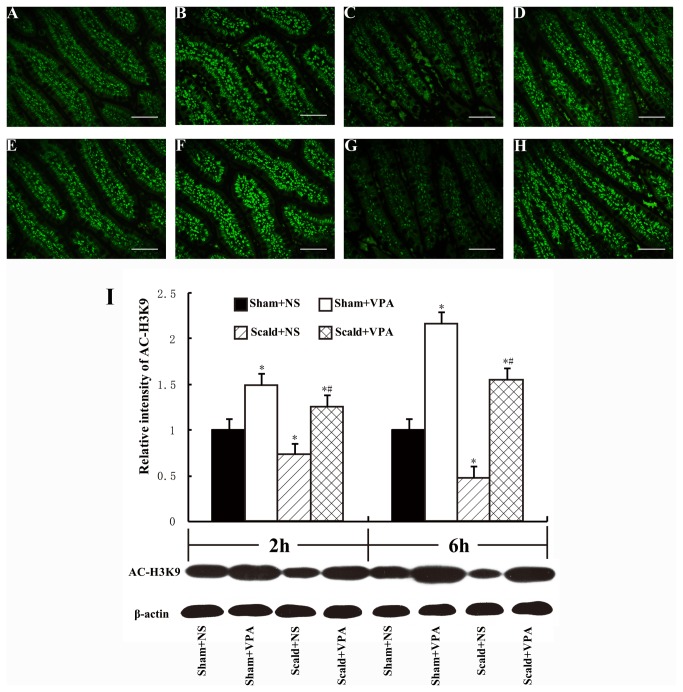
VPA increases acetylation of histone H3 at K9.Sections of distal ileum harvested 2 and 6 hours after 55% TBSA burn were labeled for Ac-H3K9 (A-H). A and E: representative image from sham+NS group showing that histone acetylation ubiquitously existed in normal intestinal cells; C and G: sections from scald+NS group at 2 and 6 hours, respectively; fluorescence intensity of Ac-H3K9 was decreased after burn injury compared to sham-burned rats; B, F and D, H: sections from sham+VPA (B, F) and scald+VPA (D, H), respectively; VPA treatment increased the fluorescence intensity of Ac-H3K9 both at sham-burned and burned rats. White bar = 100 μm. I: Western Blot analysis of intestinal Ac-H3K9. Burn insults resulted in a significant reduction in intestinal Ac-H3K9 levels and VPA treatment significantly increased the levels of intestinal Ac-H3K9 at 2 and 6 hours post-burn. Protein bands quantified by densitometry were expressed as mean values ± SD (n=5). * P < 0.05, compared with Sham+NS group. # P < 0.05, compared with Scald+NS group.